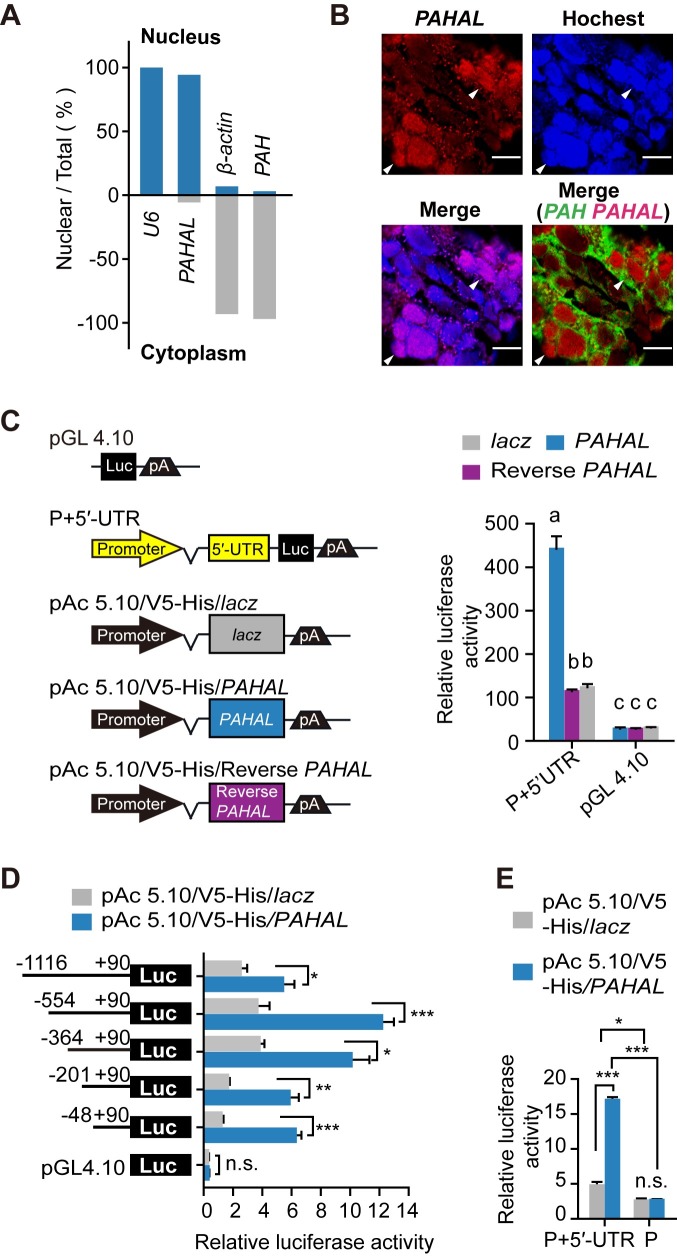
Nuclear-enriched PAHAL promotes the PAH expression by interacting with the promoter-proximal region of PAH.(A) Subcellular localisation of PAHAL and PAH in the brain. Five biological replicates of eight brains were examined for each treatment. (B) FISH detection of the PAHAL probe (red), PAH probe (green), and Hoechst 33342 (blue) in the brain. The arrows indicate the subcellular location of PAHAL (in the nucleus) and PAH (in the cytoplasm). Scale bars, 50 μM. The brain region in these images was indicated by the "b" squares of Fig 3C. (C) PAHAL-enhanced PAH promoter activity. The PAH promoter construct (P+5′-UTR) contained −1,168 to +89 bp relative to the TSS. “P” represents −1,168 to +1 bp, and “5′-UTR” denotes +1 to +89 bp. Reverse PAHAL is a reverse full-length fragment of PAHAL. Lacz is a fragment of Lacz gene containing frame shift and acted as a negative control. PAHAL, reverse PAHAL and lacz were constructed into pAC5.1/V5-His A vectors to their high-level transient expression in Drosophila S2 cells. (D) PAHAL interacts with the proximal promoter of PAH. (E) 5′-UTR of PAH is required for transcriptional activation by PAHAL. Error bars indicate ± SEM. Student’s t-test: *P < 0.05, **P < 0.01; ***P < 0.001; n.s., insignificant.